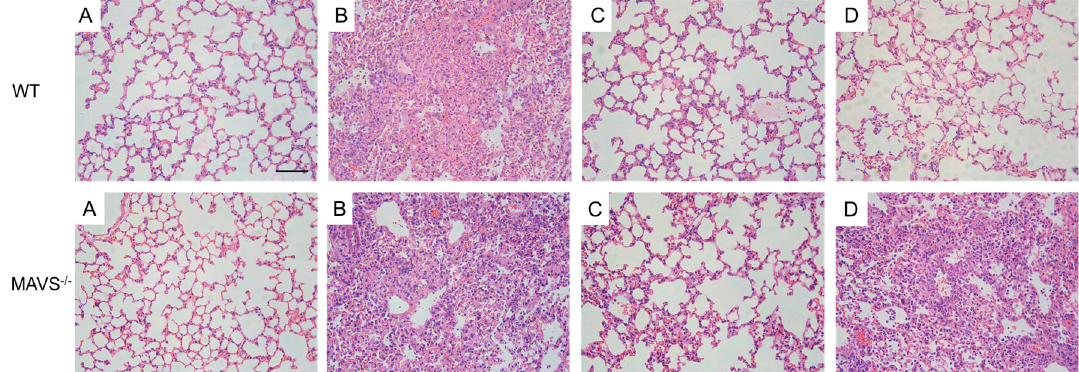
Figure 4. Lung histopathology of WT and MAVS − / − mice infected with influenza virus. At day 6 post infection, the lungs were collected and sectioned for histopathological analysis. ( A – D ) indicates the mock-treated controls, virus group, oseltamivir group, and forsythiaside A group ( n = 6). Bars = 100 μ m.